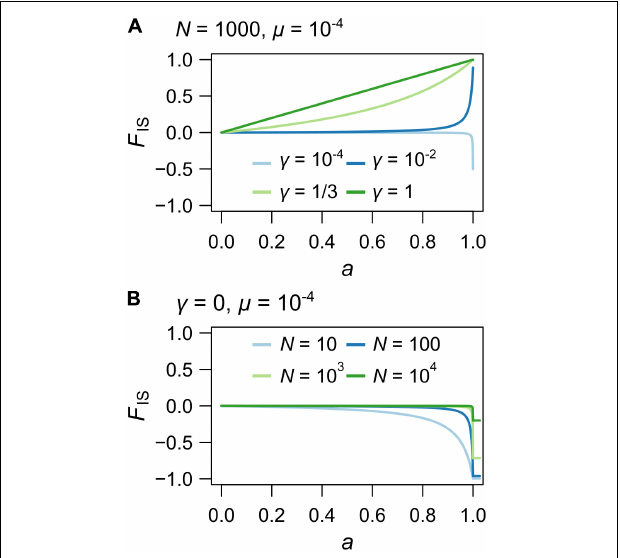
FIGURE 3 | Theoretical values of the individual inbreeding coefficient, F IS for varying rates of automixis, a . (A) Variations due to different rates of loss of heterozygosity: γ = 10 − 4 (light blue), 10 − 2 (blue), 1/3 (light green) and 1 (green). Population size was set to N = 1000 and mutation rate to µ = 10 − 4 . (B) Under automixis without loss of heterozygosity (i.e., strict apomixis; γ = 0), variations due to different population sizes: N = 10 (blue), 100 (light blue), 1000 (light red) and 10 000 (red). Horizontal bars with corresponding colors indicate the F IS values for a = 1. Mutation rate was set to µ = 10 − 4